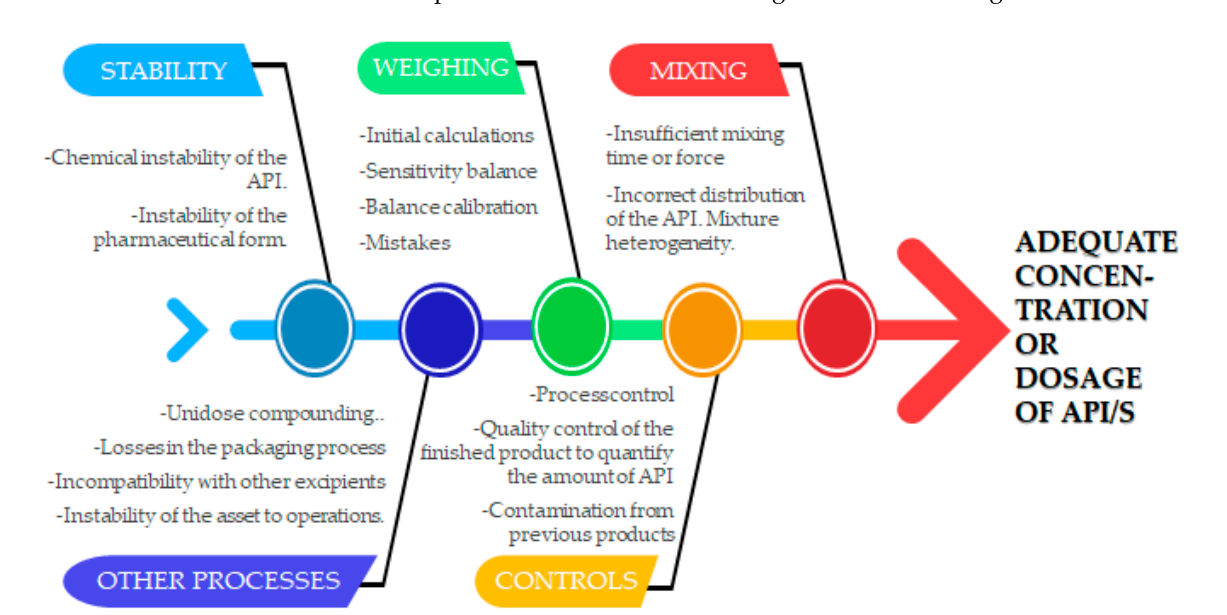
Figure 2. Ishikawa diagram with the categorization of the possible root causes that contribute to noncompliance with specifications in the adequate concentration or dosage of active pharmaceutical ingredients (APIs).